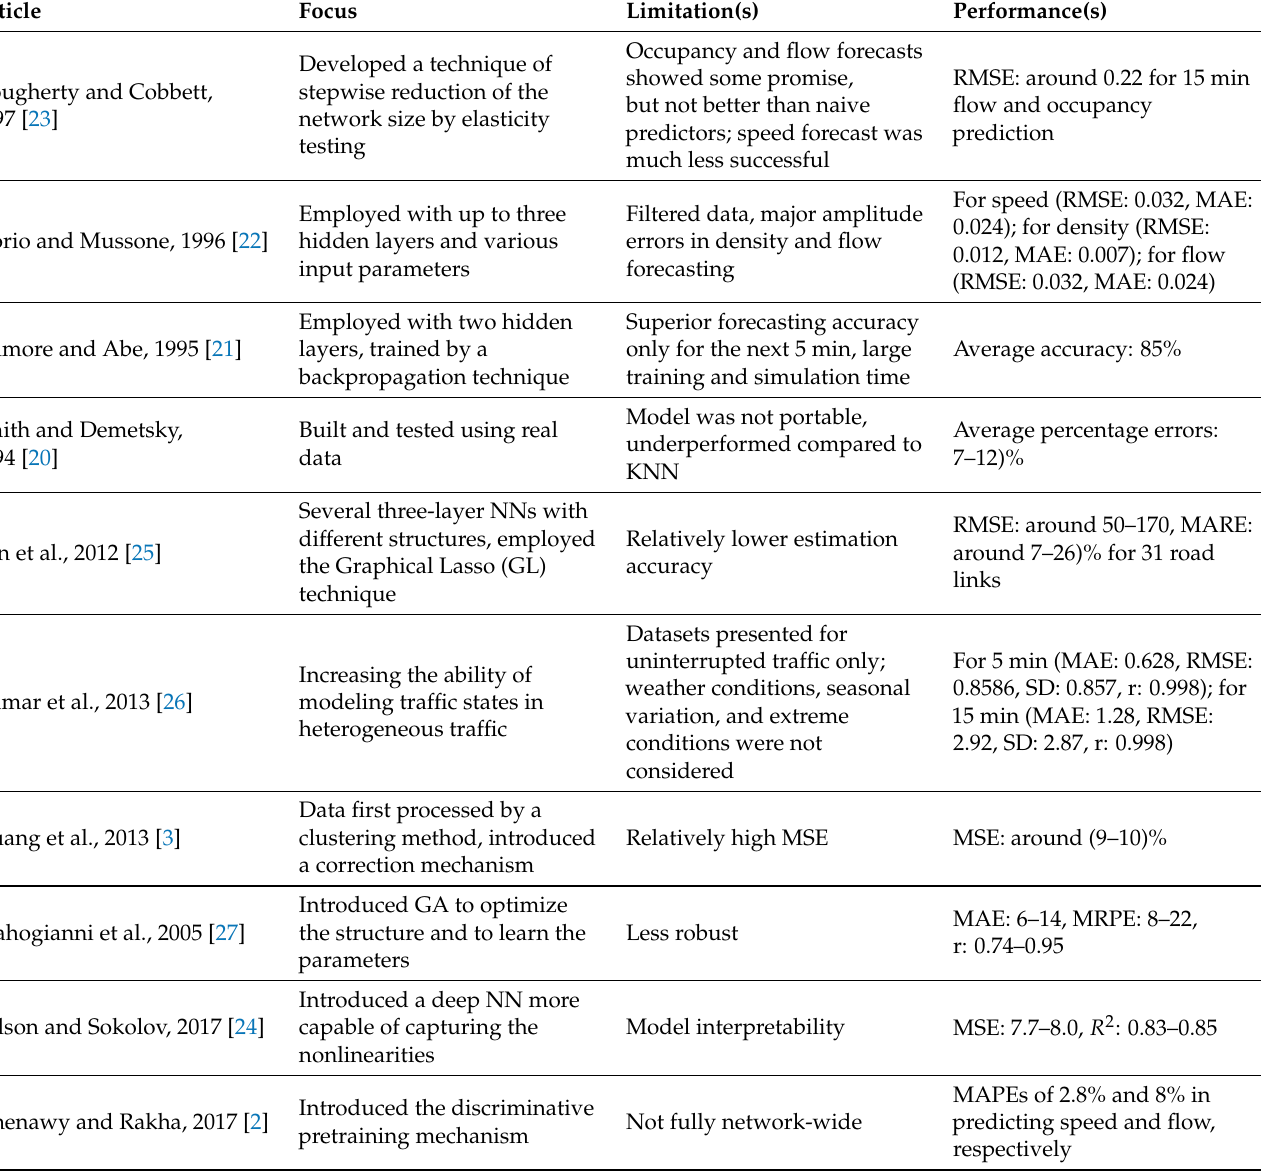
Table 1. Summary of the works found using